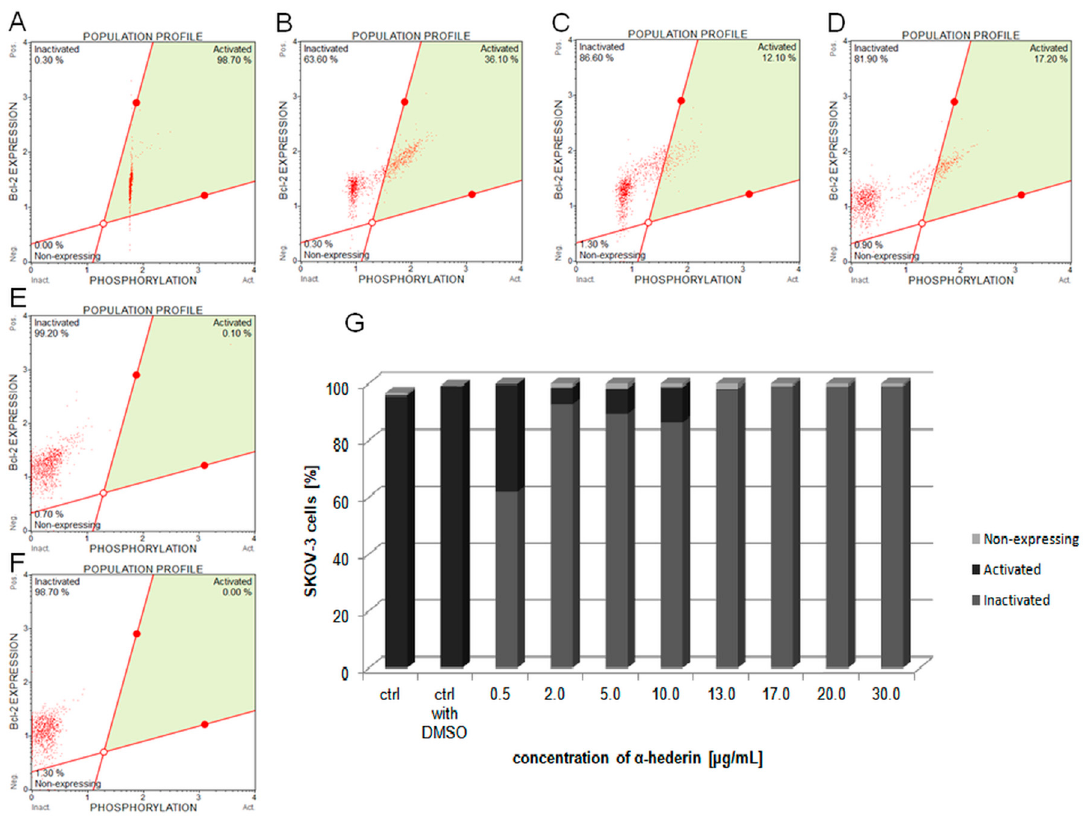
Figure 7. Estimation of Bcl-2 inactivation in SKOV-3 cells treated with α -HN. The diagrams depict the mean values of three independent experiments with the levels of anti-apoptotic protein, Bcl-2, which was measured in SKOV-3 cells that were previously treated with 0.3% DMSO (control with DMSO) ( A ) and the increasing concentrations of α -HN in the range 0.5–30 µ g / mL for 24 h (particular concentrations are represented in pictures: 0.5 ( B ), 2 ( C ), 10 ( D ), 17 ( E ), and 30 µ g / mL ( F )). The results are presented as percentages of non-expressing, activated (via phosphorylation), and inactivated cells ( G ). Control: The untreated cells.